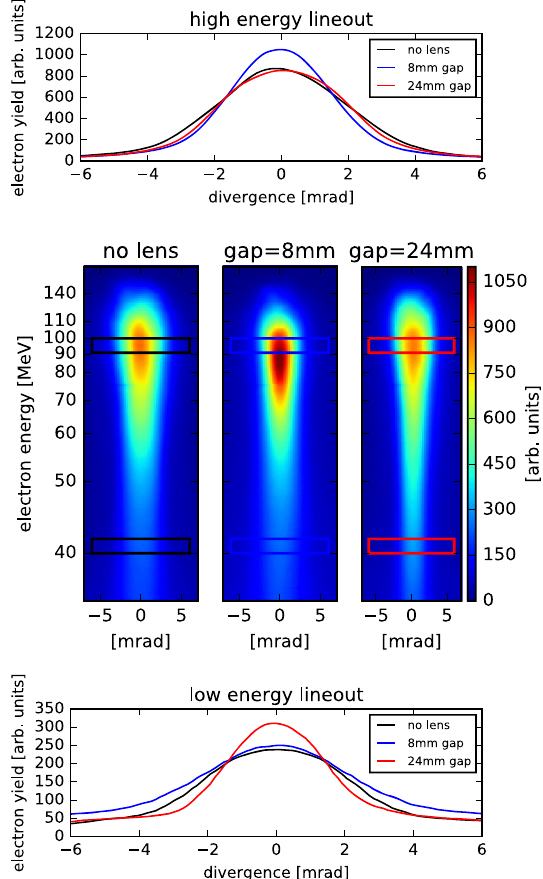
FIG. 7. Spectral dependence of the lens for three single shots: The plots are equal to Fig. 6, but with only three single shots presented. The same behavior as in Fig. 6 can be observed: The high energy electrons are focused at 8 mm gap length (blue) whereas the low energetic electrons are focused at 24 mm gap length (red). This shows that the effect of plasma lensing can be observed in the single-shot data and the averaged